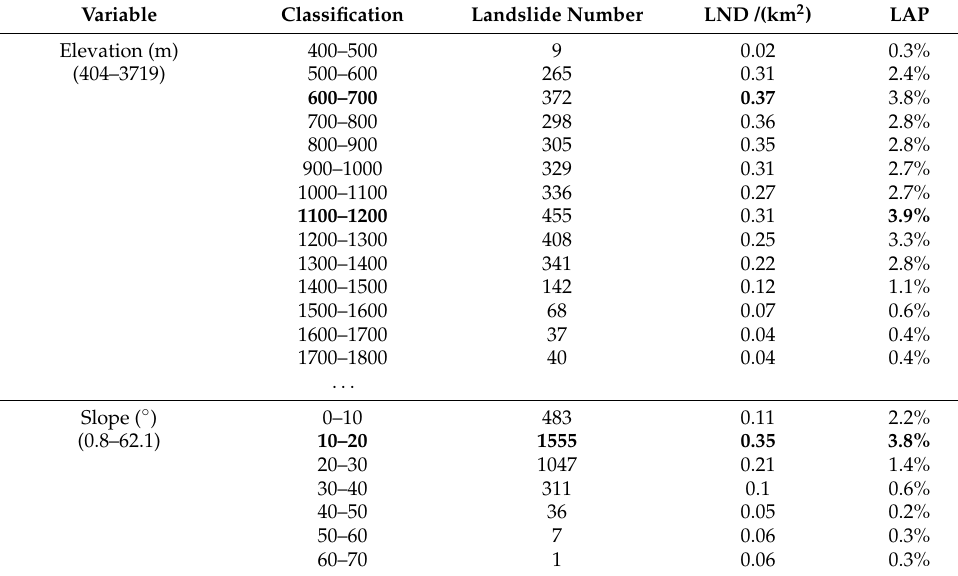
Figure 13. The LND distribution map derived from this study. Table 4. LND and LAP for each classification of 8